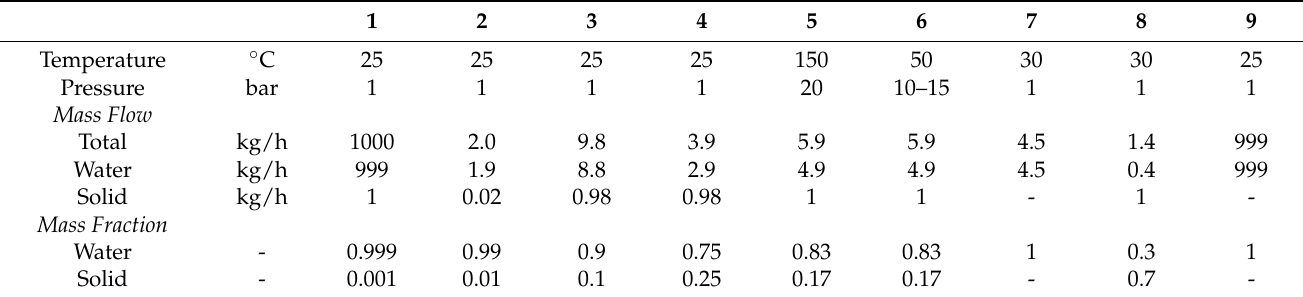
Table 5. Material and energy balances of the process schematically shown in Figure